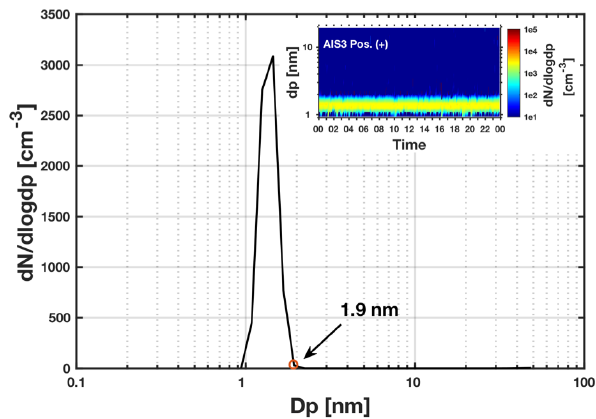
Figure 1. The median size distribution of positive ions measured by the AIS on an event-free day (16 January 2011). The measured number size distribution of this day is shown in the contour